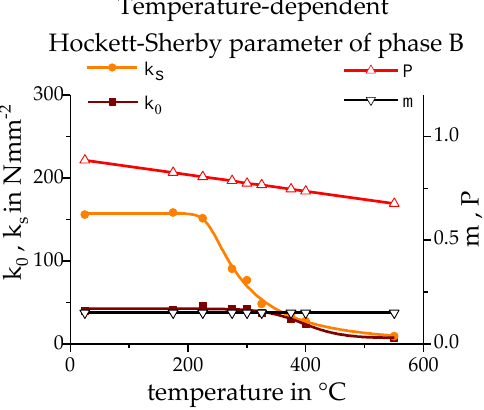
during cooling after the 400 °C maximum temperature, phase (B).